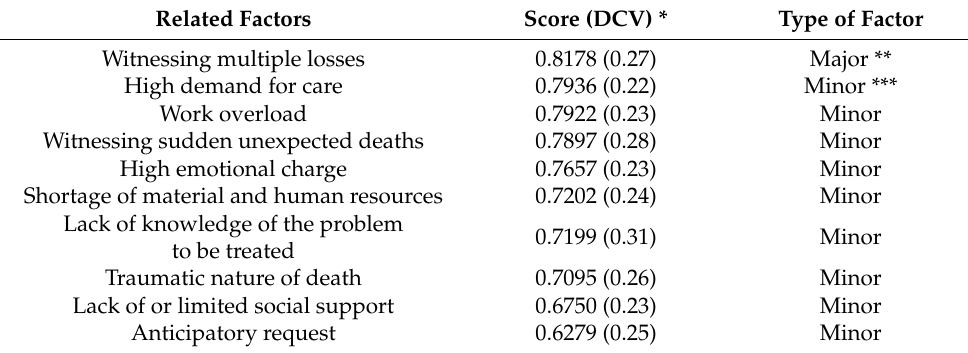
Table 3. DCV scores for each of the related